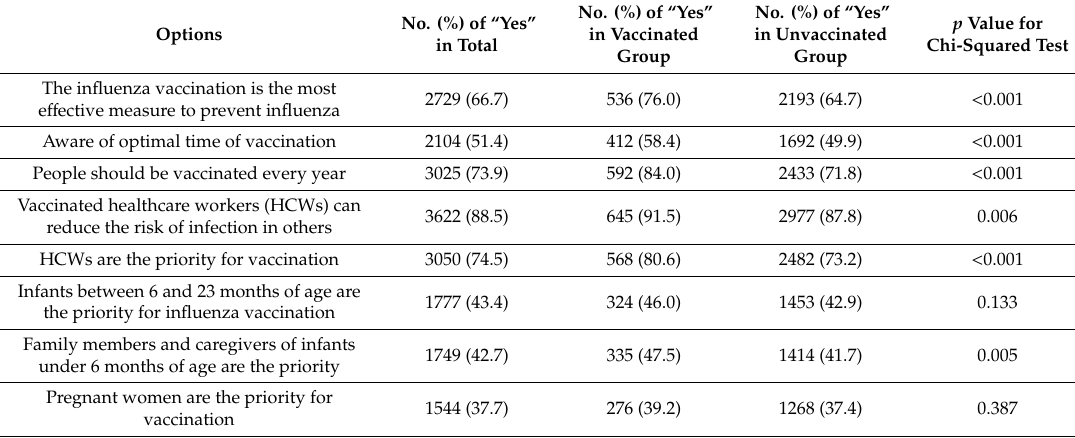
Table 2. Knowledge about the influenza vaccination among vaccinated and unvaccinated healthcare workers in Xining City, Qinghai,